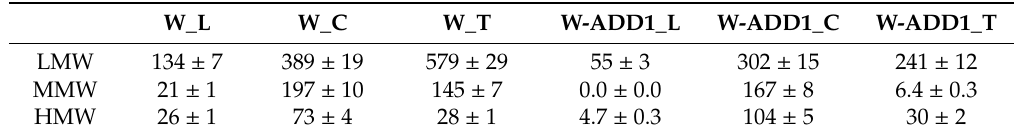
Table 4. Recovery of biophenols in water fractions. Data, expressed in mg / L, are mean ± standard